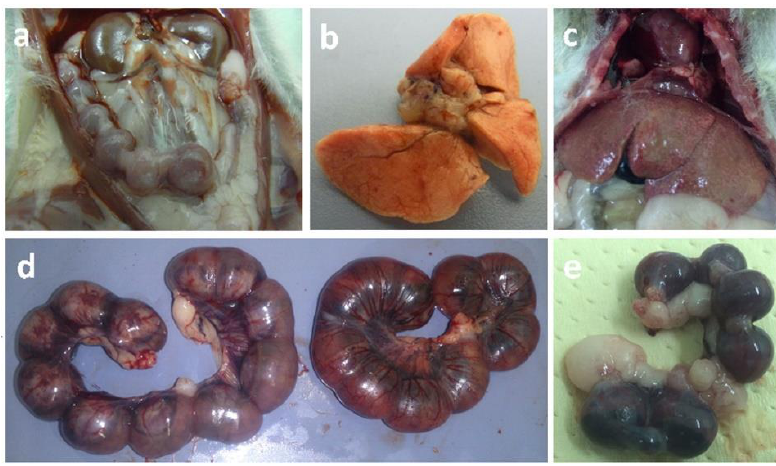
Figure 2. ( a ) The uterus of pregnant hamster inoculated with EHV-9 at the 1st trimester (5th day of gestation) revealed an ischemic white pregnancy cyst in comparison with surrounding cysts at 3 dpi. ( b ) Liver of pregnant hamster inoculated with EHV-9 in the 1st trimester (5th day of gestation) revealed pinpoint necrosis of the liver with sharp demarcation of lobules, 6 dpi. ( c ) Lungs of pregnant hamster inoculated with EHV-9 in the 1st trimester (5th day of gestation) revealed pinpoint hemorrhages, 3 dpi. ( d ) The uterus of pregnant hamster inoculated with EHV-9 in the 1st trimester (5th day of gestation) revealed severe congestion with hemorrhagic dark areas (right) at 6 dpi compared to control gravid uterus (11 days of gestation). ( e ) The uterus of pregnant hamster inoculated with EHV-9 in the 1st trimester (5th day of gestation) revealed a small dark pregnancy cyst in comparison with surrounding cysts at 6 dpi.